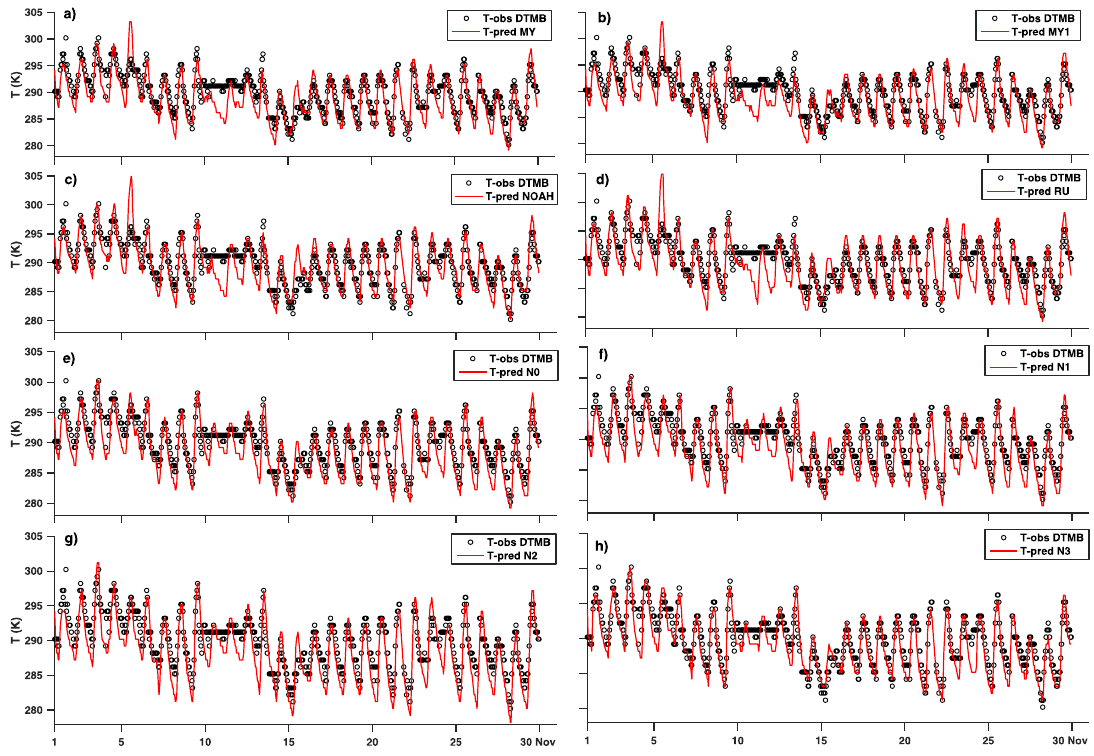
Figure 2. Time series of temperature (T) observed at DTMB meteorological station versus T predicted by MY ( a ), MY1 ( b ), NOAH ( c ), RU ( d ), N0 ( e ), N1 ( f ), N2 ( g ), and N3 ( h ) simulations.